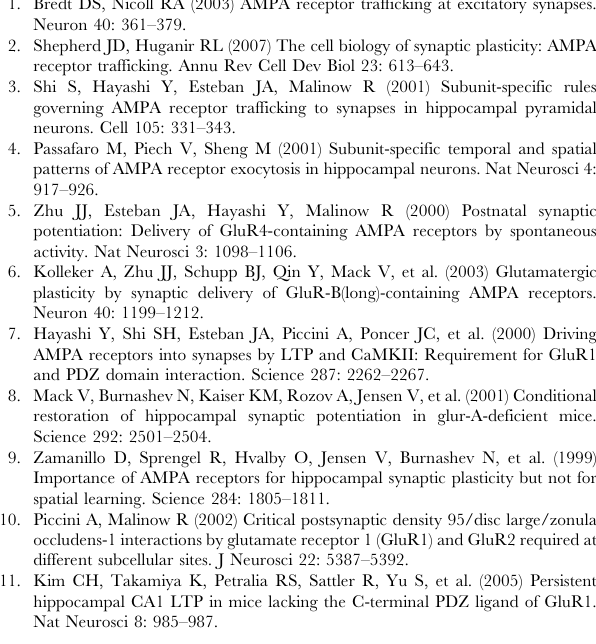
mLin-2. In rat cerebellar tissue extract (CB) the anti-PDZ serum detects multiple bands, as expected. Figure S3 Characterization of an antibody specific for the exposed PDZ motif in GluA4 D P. (A) Immunofluoresence labelling of PFA-fixed Cos-7 cells transfected with the indicated constructs. All the subunits are expressed as shown by anti-flag labelling. However, anti- D P IgG recognises only GluA4 D P, not wildtype GluA4. (B) Specific ablation of signal by pre-incubation of antibody with peptide. Pre-incubation of anti- D P IgG with molar excess of 13mer peptide prevented detection of recombinant GluA4 D P, similar treatment with 14mer peptide had no effect (left hand panels). Conversely, anti-GluR4 was only fully blocked with the 14mer peptide (right hand panels). Figure S4 Anti- D P IgG recognizes rat dynamin1 C-terminus. (A) Rat cerebellar extract was immunoprecipitated by a panel of antibodies indicated on top and the samples were probed as indicated to the left. A 100-kDa dynamin band is present in the input and in anti- D P immunoprecipitate, but not in anti-BD L or Fab7 immunoprecipitates (upper panel). Conversely, anti- D P and dynamin immunoprecipitates do not contain any detectable GluR4 immunoreactivity (lower panel). (B) HEK293 extracts containing GFP-dynamin 1[845-864] fusion protein or GFP only were immunoprecipitated with anti-GFP and immunoblotted with anti- D P IgG. Anti- D P reacted strongly with the 27-kDa dynamin fusion but not with GFP (upper panel). Both proteins were similarly expressed, as shown by the anti-GFP blot (lower panel; the lower bands correspond to IgG). Figure S5 Effect of deletion of the carboxyterminal serine residue on immunoreactivity and PDZ interactions of GluA2 L .(A) The anti- D P IgG recognizes the exposed PDZ motif in GluA2 L D S. HEK293 cells expressing Flag-tagged GluA2 L and GluA2 L D S proteins were immunoblotted with the antibodies indicated below the panels. The anti-BD L IgG detects both proteins, whereas anti-